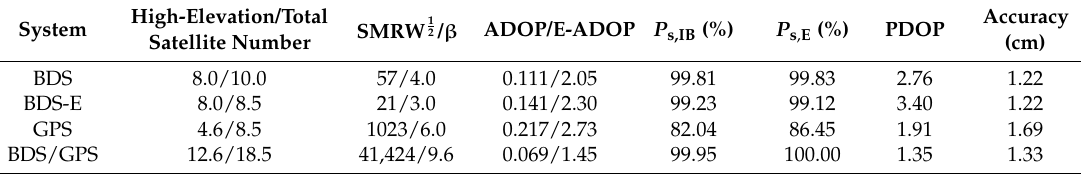
Table 6. Results of BDS, BDS-E, GPS and